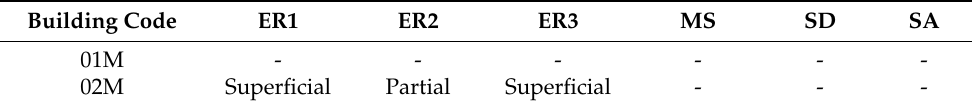
Table 7. Material weathering on monumental architecture.